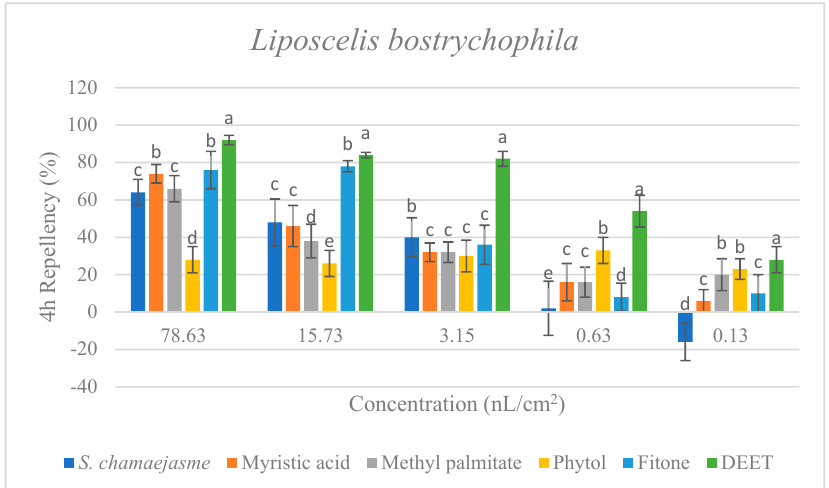
Figure 4. Percentage repellency (PR) of EO from S. chamaejasme and main monomeric compounds against T. castaneum , L. serricorne , and L. bostrychophila at 2 and 4 h after exposure. The meaning of the letters a, b, c, d, e in figures means in the same column followed by the same letters do not differ significantly in the tests of ANOVA and Tukey ( p > 0.05).